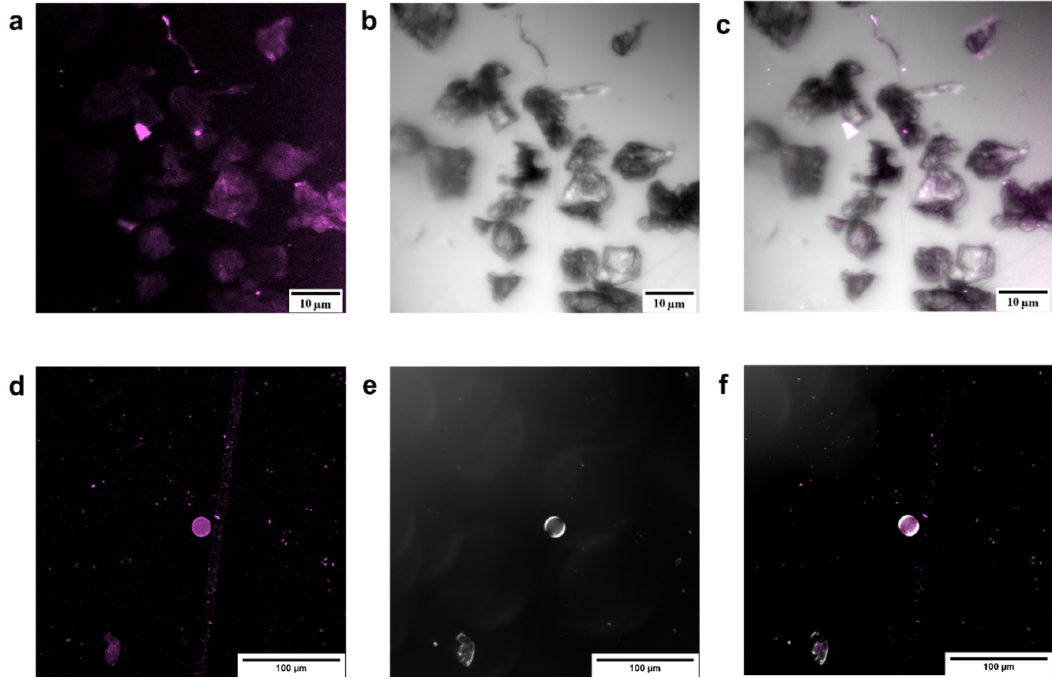
Figure 2. Confocal microscopy images of AC-C and PSS-C at magnification 40x. ( a ) AC-C and RhB fluorescence with 599 nm laser, ( b ) AC-C transmission image, ( c ) merging of ( a , b ) channels, ( d ) PSS-C and RhB fluorescence with 599 nm laser, ( e ) PSS-C transmission image, and ( f ) merging of ( d , e ) channels.